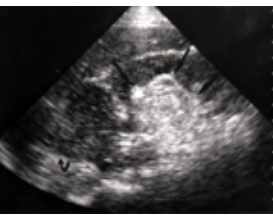
FIGURE 3 . Longitudinal sonogram of the right kidney confirms the presence of an isoechoic mass of the upper pole (curved arrows) and a seperate echogenic mass (arrows) in mid and lower